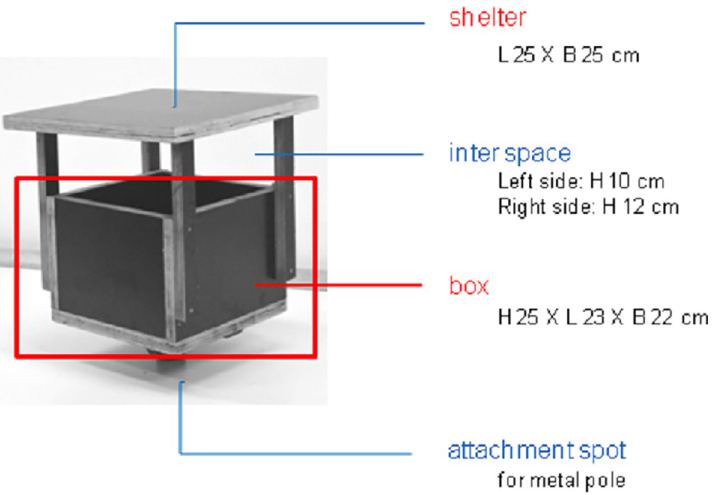
Fig 1. Boxes mounted upon poles to investigate marine nematode dispersal through air in the field. Wooden boxes (H 25 x L 23 x W 23 cm) with shelter, containing 200 g defaunated algae, were placed on metal poles ca. 1.75 m above sediment level amidst salt marsh